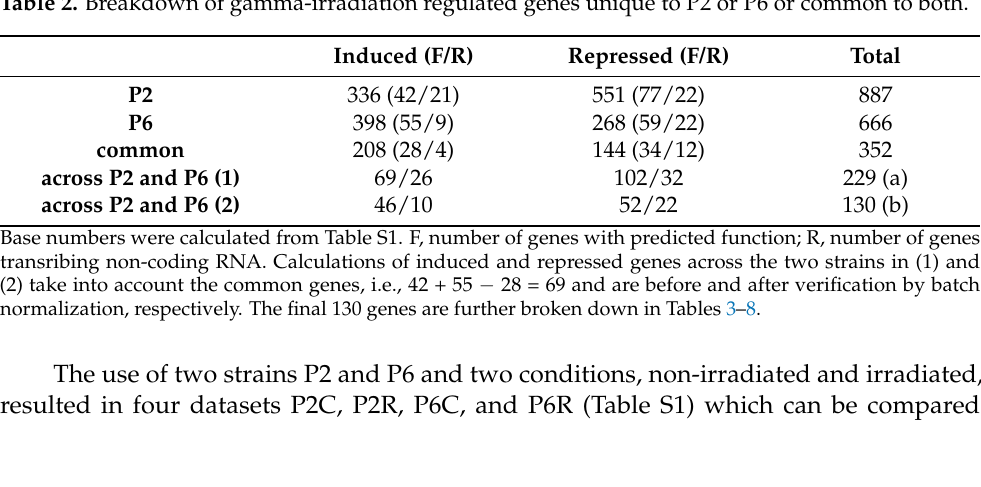
Table 2. Breakdown of gamma-irradiation regulated genes unique to P2 or P6 or common to